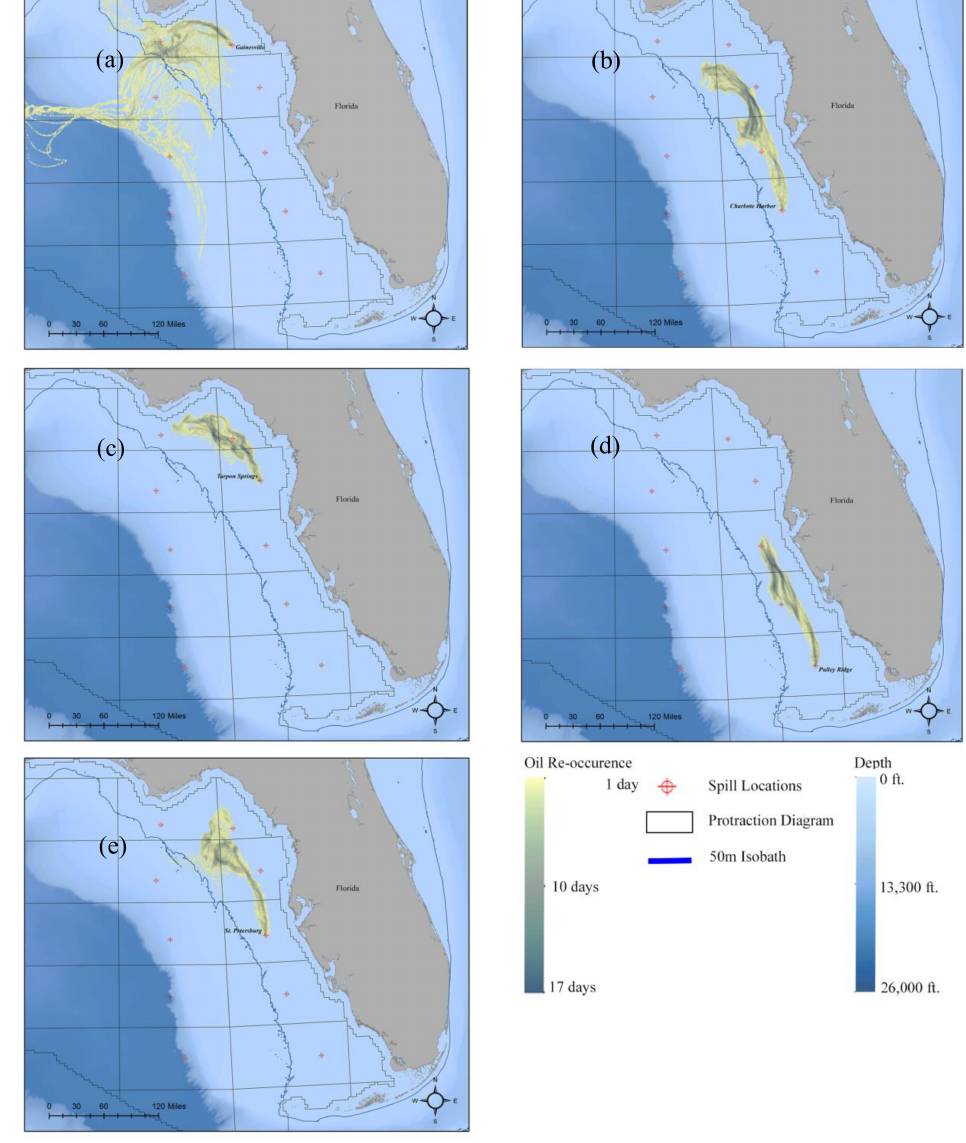
Figure 3. Eastern scenarios plume extent and shape over the course of the 60 day simulation period. ( a ) (top left) depicts the plume from the Gainesville scenario. ( b ) (top right) depicts the plume from Charlotte Harbor. ( c ) (middle left) depicts the Tarpon Springs plume. ( d ) (middle right) depicts the Pulley Ridge plume and ( e ) (bottom left) depicts the St. Petersburg plume. The plume is represented by the number of days that new oil particles moved through a specific